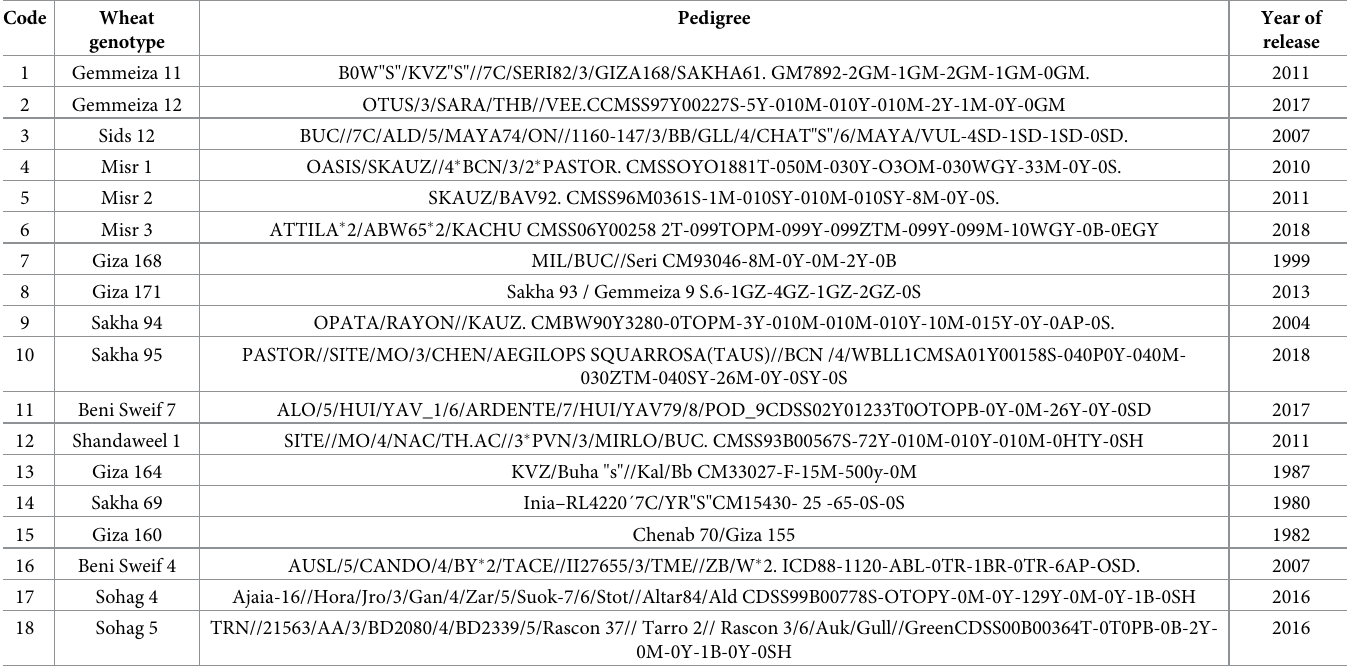
Table 1. Pedigree and year of release of the tested wheat